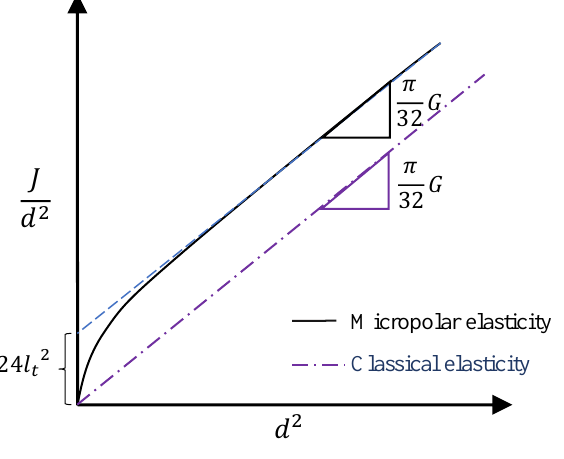
Figure 3. Plot of torsional rigidity divided by the square of the diameter vs. the square of the external diameter to characterize Cosserat